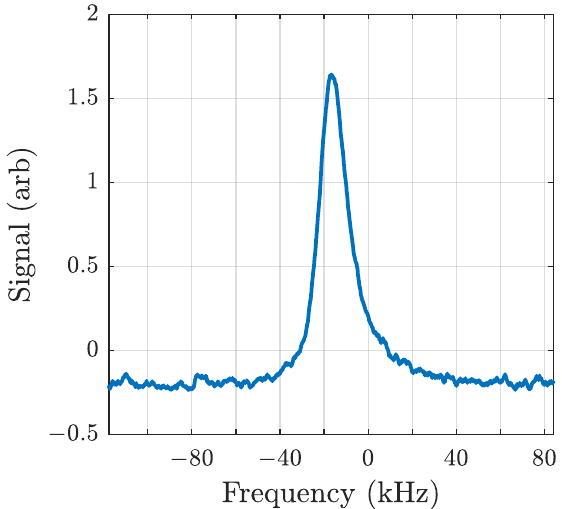
Figure 12. Experimentally measured clock transition in the Doppler-free configuration. The peak is not centered about 0 detuning because of the presence of a small second-order Zeeman shift.